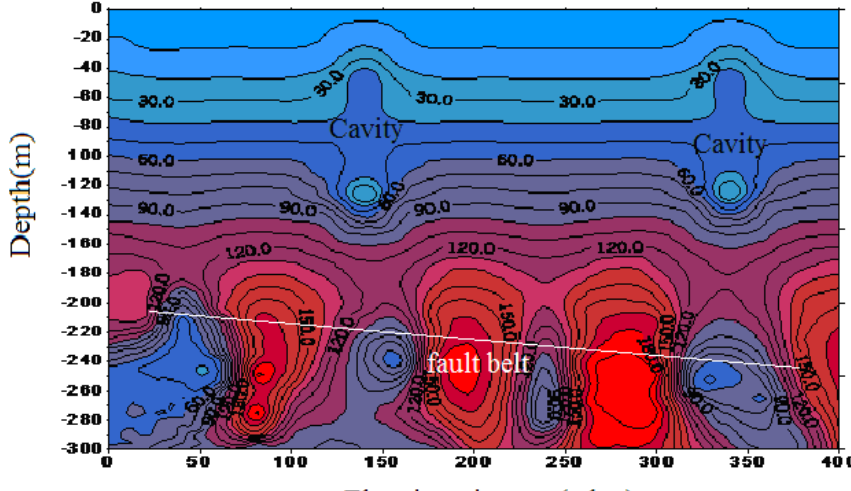
Figure 1. Electromagnetic exploring for cavity identification.